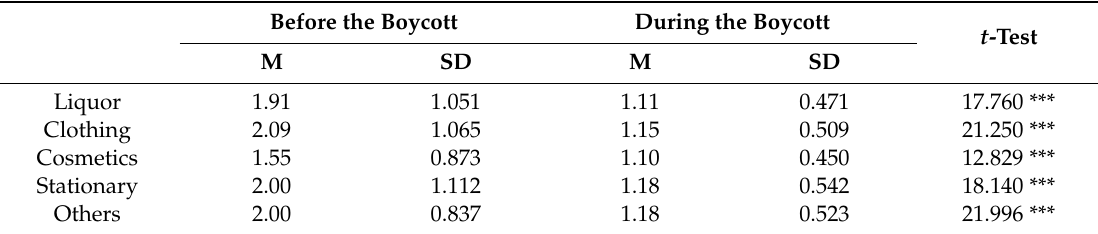
Table 3. Purchasing levels before and during the